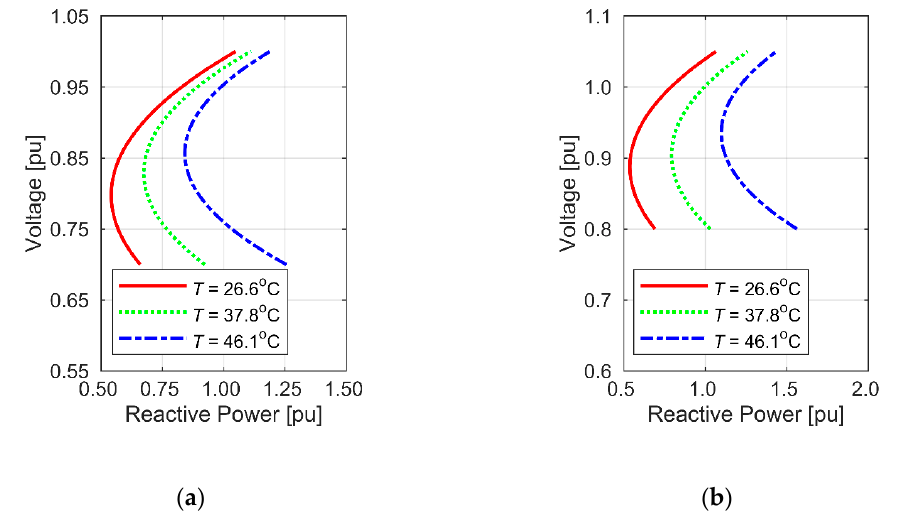
Figure 5. Reactive power characteristics of a residential air conditioner (RAC) during normal conditions (elaborated base on [29]): ( a ) research by the Electric Power Research Institute (EPRI); ( b ) research by Southern California Edison.